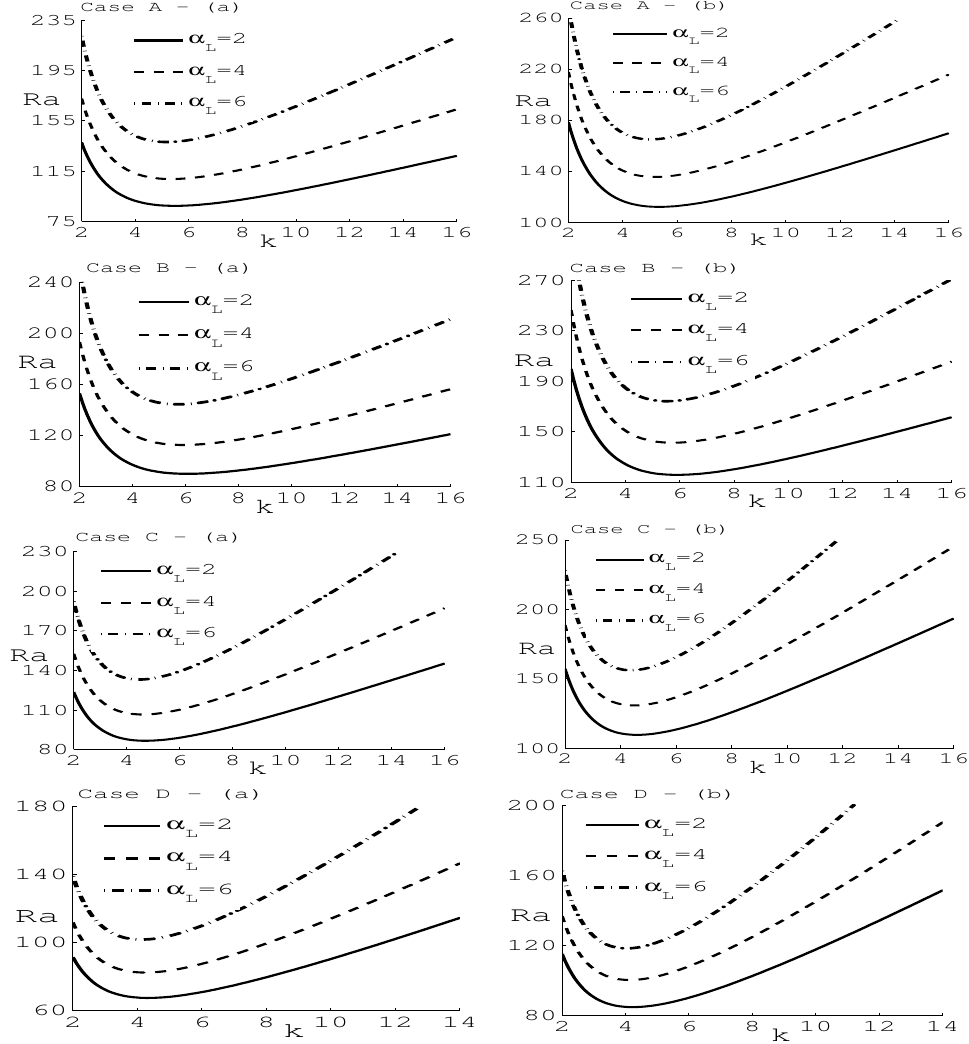
Figure 2. Neutral curves for different values of the Langevin parameter α L for ( a ) water-based ferrofluid and ( b ) ester-based ferrofluid for Case A to Case D. The fixed parameter values are d = 0.001 m, (cid:101) = 0.35, and K = 2.0 × 10 − 7